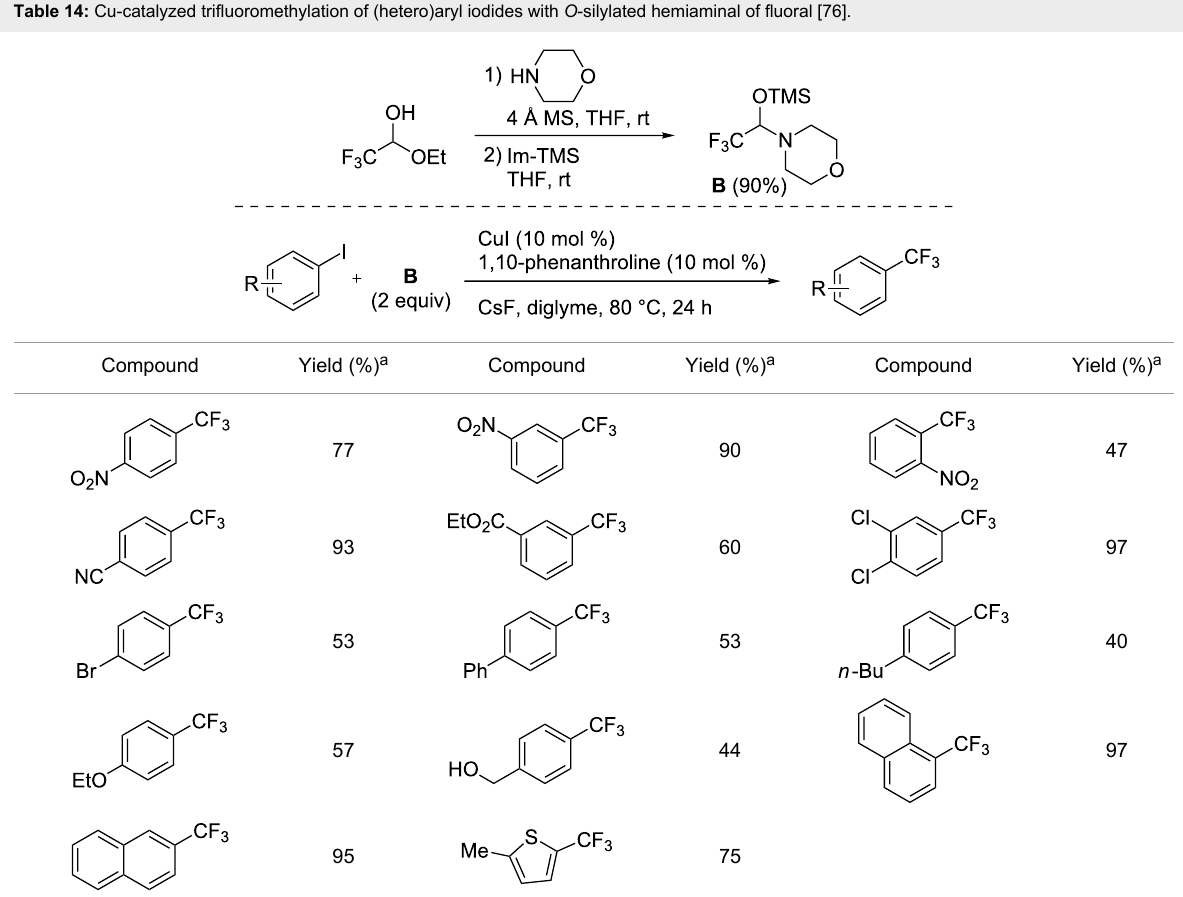
Table 14: Cu-catalyzed trifluoromethylation of (hetero)aryl iodides with O -silylated hemiaminal of fluoral